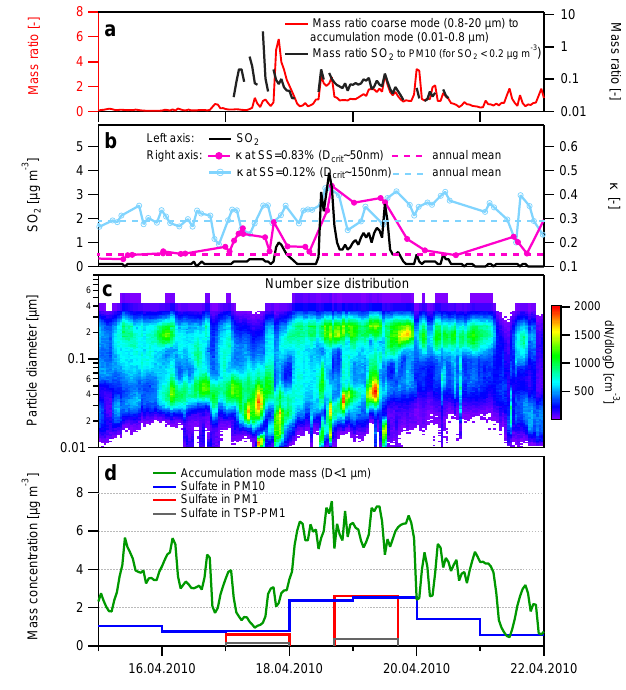
Fig. 3. Temporal evolution of PM 0 . 8 − 20 /PM 0 . 8 , SO 2 /PM 10 (a) , sulfur dioxide, hygroscopicity parameter κ (b) , number size distri- bution (c) , sulfate and accumulation mode mass concentration (d) , measured at the Jungfraujoch during the volcanic aerosol episode in April 2010. The accumulation mode mass concentration is es- timated from the linked SMPS and OPC size distributions and as- sumes a density of 1.6gcm − 3 . The indicated κ values are derived from the instrumental supersaturation (SS) and the critical activa- tion diameter ( D crit ).